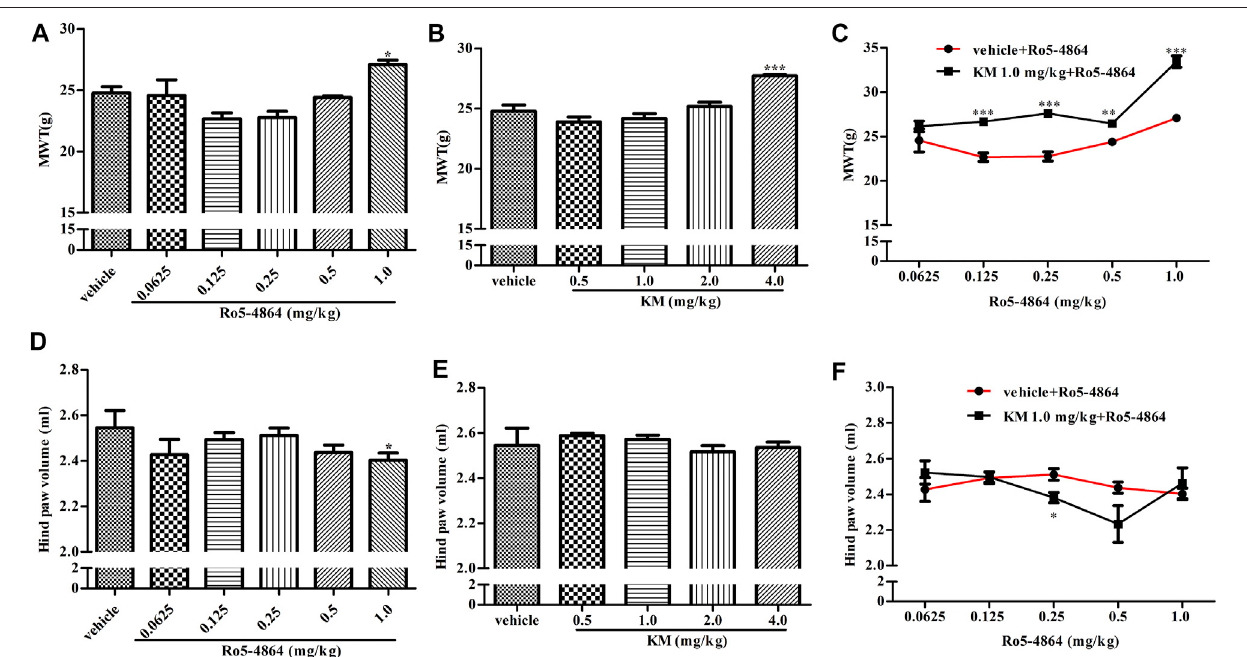
FIGURE 4 | Modulation of the in vivo ef fi cacy of Ro5-4864 by koumine successive administration in the rat model of CIA. (A,B,D,E) Effects of repeated administrationsofRo5-4864 (A,D) orkoumine (B,E) onMWT (A,B) andhindpawvolume (D,E) . (C,F) DoseresponseeffectsontheMWT (C) andhindpawvolume (F) of Ro5-4864 in the absence or presence of koumine (1.0 mg/kg). Seven-week-old Lewis rats were immunized with bovine type II collagen in IFA. Immunized rats received Ro5-4864,koumineorvehicleforsevenconsecutivedaysbeginningfromday29afterthe fi rstcollageninjection.TheMWTwasdeterminedonday35,andthehind paw volume was measured 60 min following the MWT determination for each rat. Koumine or vehicle was injected s. c., and MWT values were determined 60 min after koumine injection. Ro5-4864 or vehicle was injected i. p., and MWT was determined 50 min after Ro5-4864 injection. To determine whether koumine potentiated the effects of Ro5-4864, koumine (1.0 mg/kg, s. c.) or vehicle was injected 10 min before Ro5-4864 (0.0625 – 1.0 mg/kg, i. p.) injection, and the MWT was determined 50 min after the last injection. Abbreviations; KM: koumine, MWT: mechanical withdrawal threshold. Data are represented as the mean ± SEM, * p < 0.05, ** p < 0.01,